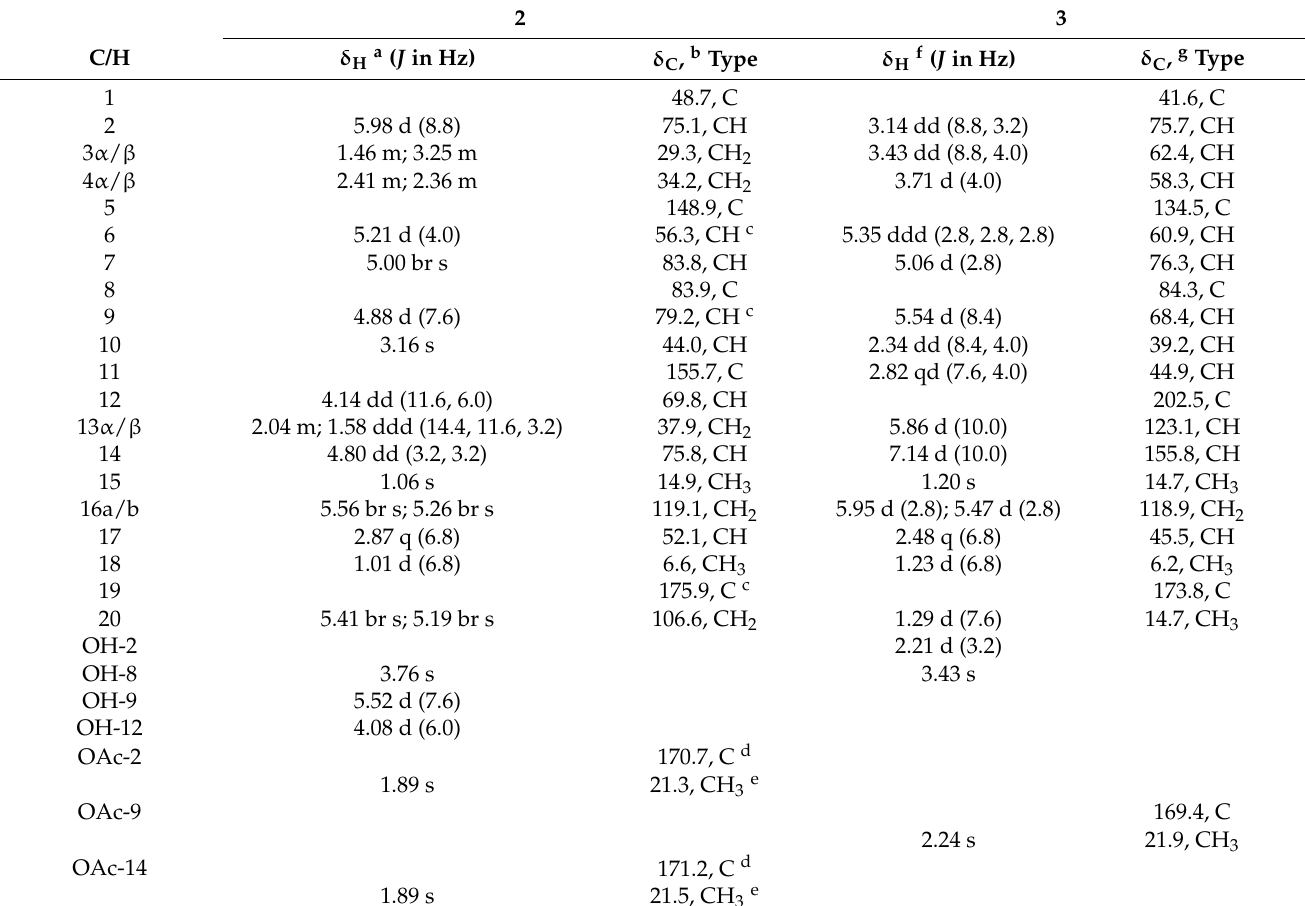
Table 1. 1 H and 13 C NMR data for briaranes 2 and 3 ( δ in